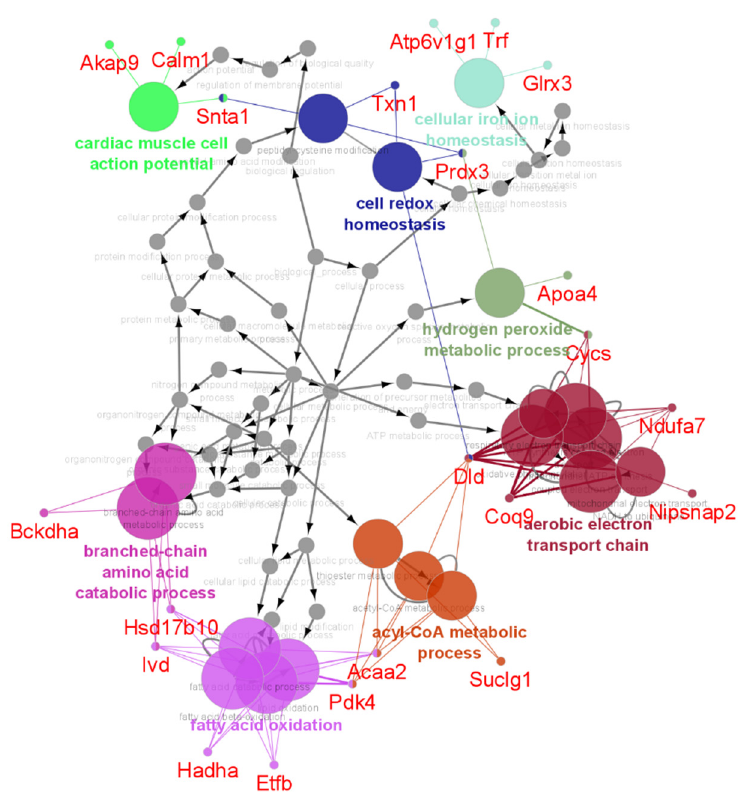
Figure 5. ClueGO analysis of biological processes of the unique proteins and DEPs between DMB vs. vehicle at each time point. A cross-comparative analysis was done at each time point (1, 3 or 7 days after PCAL) to identify the unique proteins and DEPs ( p < 0.05). A list containing all unique proteins and DEPs for each time point was uploaded on ClueGO and biological processes were obtained. ( A ) Biological processes modulated by DMB on day 1 post-PCAL; ( B ) biological processes modulated by DMB on day 3 post-PCAL; ( C ) biological processes modulated by DMB on day 7 post-PCAL.